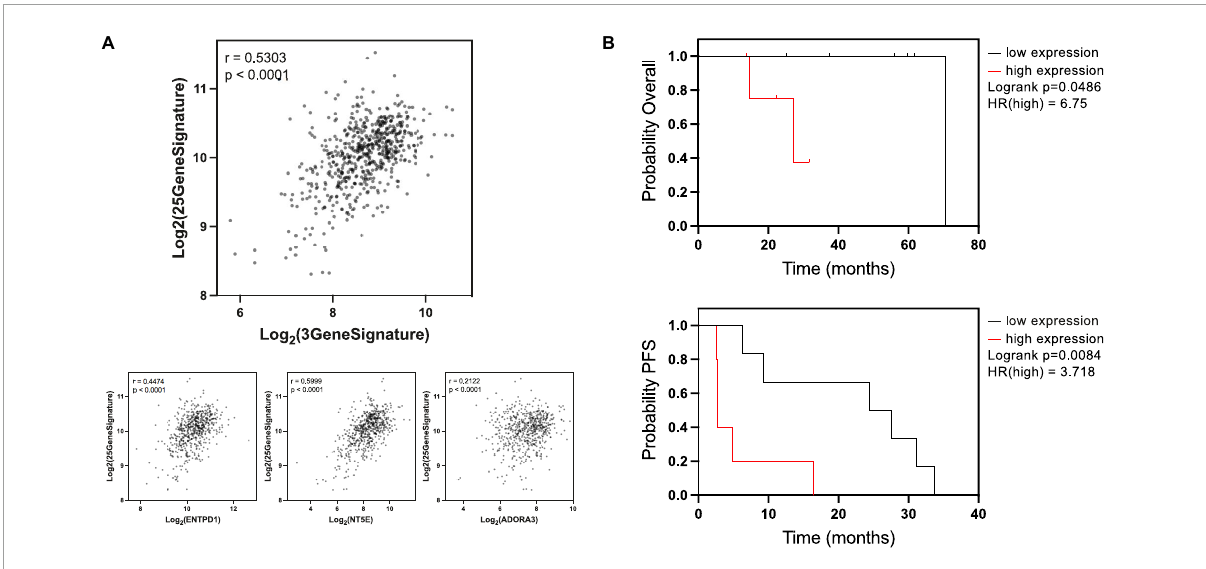
FIGURE2 ENTPD1/NT5E/ADORA3 signature is correlated with breast cancer osteotropic signature and lower survival in bone patients with established bone metastases. (A) A previous study (28) found 25 genes to be upregulated in circulating breast cancer cells from patients with bone metastases compared to patients with extraskeletal metastases, forming a putative bone metastasis-specific signature. We compared ENTPD1/NT5E/ADORA3 expression signature to the 25-gene osteotropic signature in the ER + TCGA BRCA cohort. A strong Pearson correlation ( r = 0.5303) was observed. Individually, ENTPD1, NT5E, and ADORA3 were each correlated r > 0.2. These data imply that the 3-gene signature is not an overall metastasis marker in ER + breast cancer and is specifically associated with bone metastasis. (B) Kaplan Meier plots displaying overall and progression-free survival in patients with ER + breast cancer bone metastasis. In GSE124647, gene expression was measured in bone biopsy samples. We split this cohort into high- and low-expressing ENTPD1/NT5E/ADORA3 signature (calculated by the average expression [log2(norm_count + 1)] of the three genes, and separated by median). In this n = 13 cohort, high 3-gene signature expression was associated with lower overall (HR = 6.75) and progression-free (HR = 3.718) survival, further suggesting ectonucleotidase and ADORA3 expression enables breast cancer growth in the bone microenvironment. * p < 0.05; ** p < 0.01; **** p <